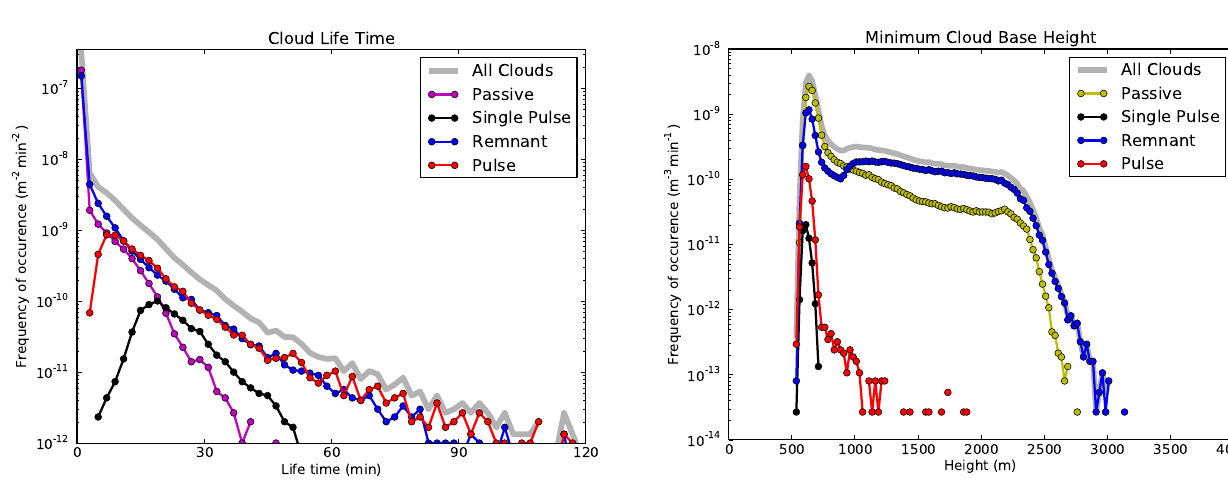
Fig. 9. Histogram of the cloud lifetime for all clouds, and for the different cloud types.